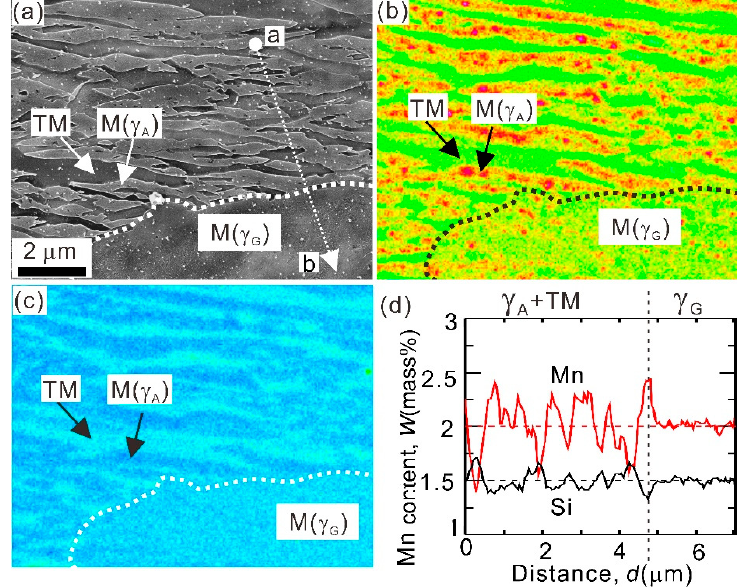
Figure 3. ( a ) SEM image of the specimen quenched from 1073 K heated at a rate of 1 K/s. EPMA maps of ( b ) Mn ( c ) Si taken from the same area as ( a ). ( d ) Mn and Si profiles along the dotted line ab in ( a